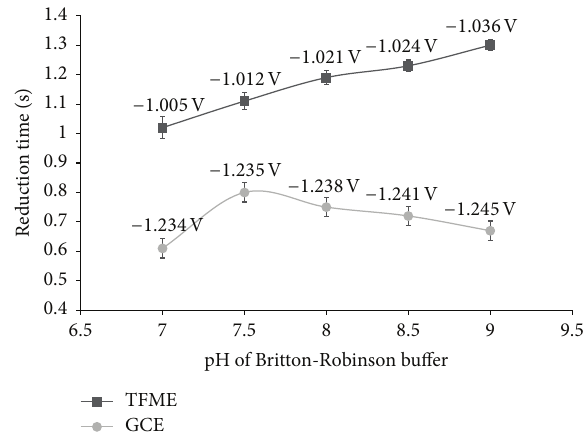
Figure 2: Effect of pH of BR buffer on the reduction time (s) and reduction peak potential (V) on TFME and GCE. Concentration of imidacloprid 10mg/L, mean ± 2SD, 𝑛 = 5